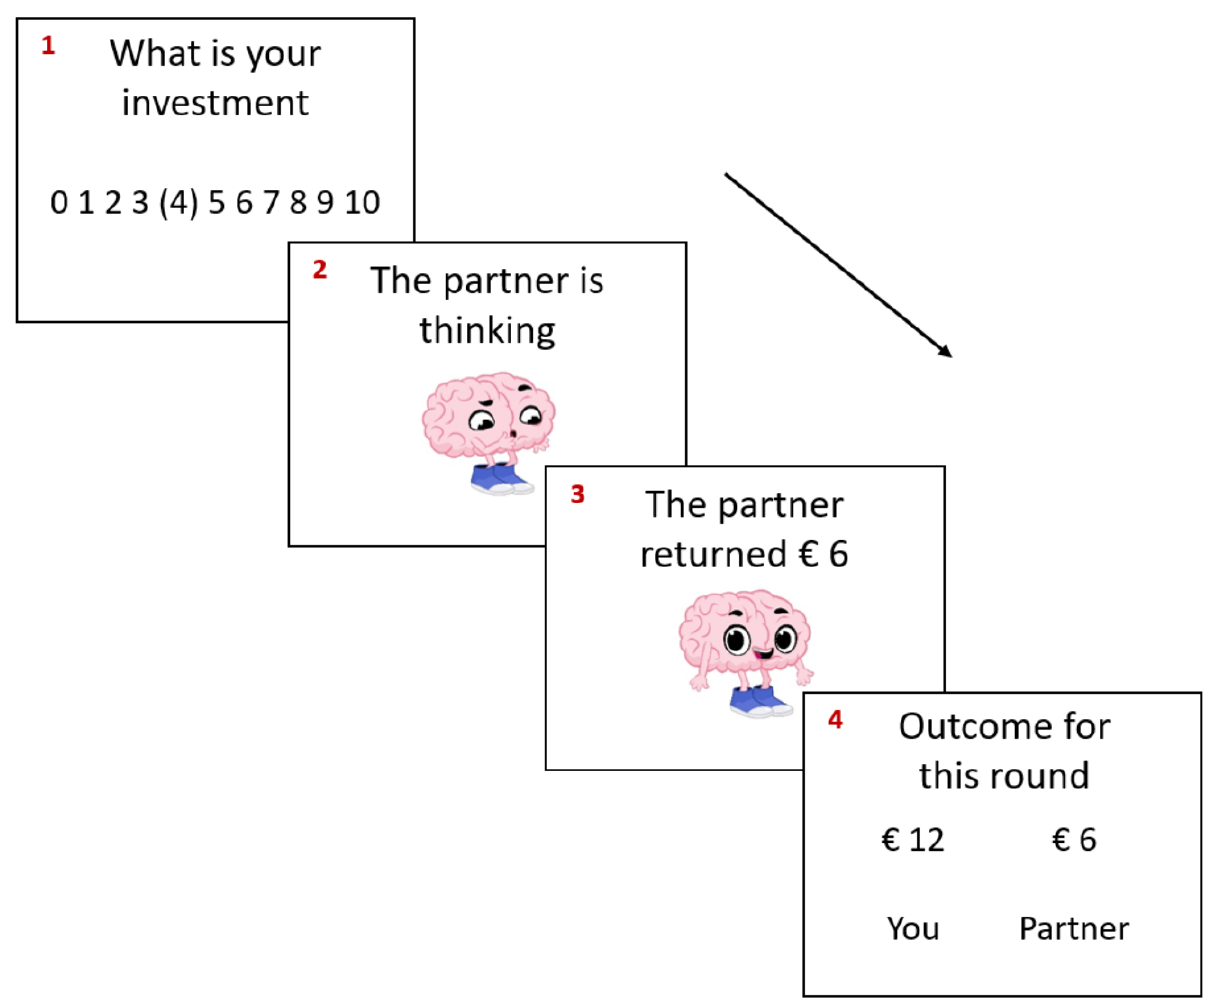
Figure 1. An example of a trial in the trust game in the trustworthy condition. Note: The investment is EUR 4, which is multiplied by 3. This means the partner received EUR 12, and the participant kept EUR 6. The partner’s return is EUR 6. Thus, the outcome of this round is EUR 12 for the participant and EUR 6 for the partner. In this example, the factor that determined the partner’s return was 1.5. The partner’s return for each trial was determined by the participant’s investment multiplied by a factor. In both conditions, the factor for the first trial was randomly selected from the values 1.2, 1.3, and 1.4. The value of the factor for the second through to the fifth trial increased by 0.1 when the participant’s investment increased compared to their investment during the previous trial (in steps of 0.1, with a minimum factor of 1.2 and a maximum factor of 1.4). The value of the factor stayed the same when the investment decreased or when the investment did not change compared to the previous trial. From the sixth trial onwards, the algorithm determining the partner’s return differed between the